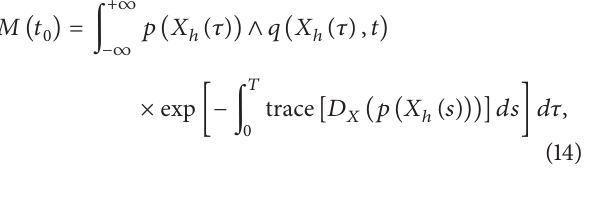
Figure 5: Bifurcation diagram using